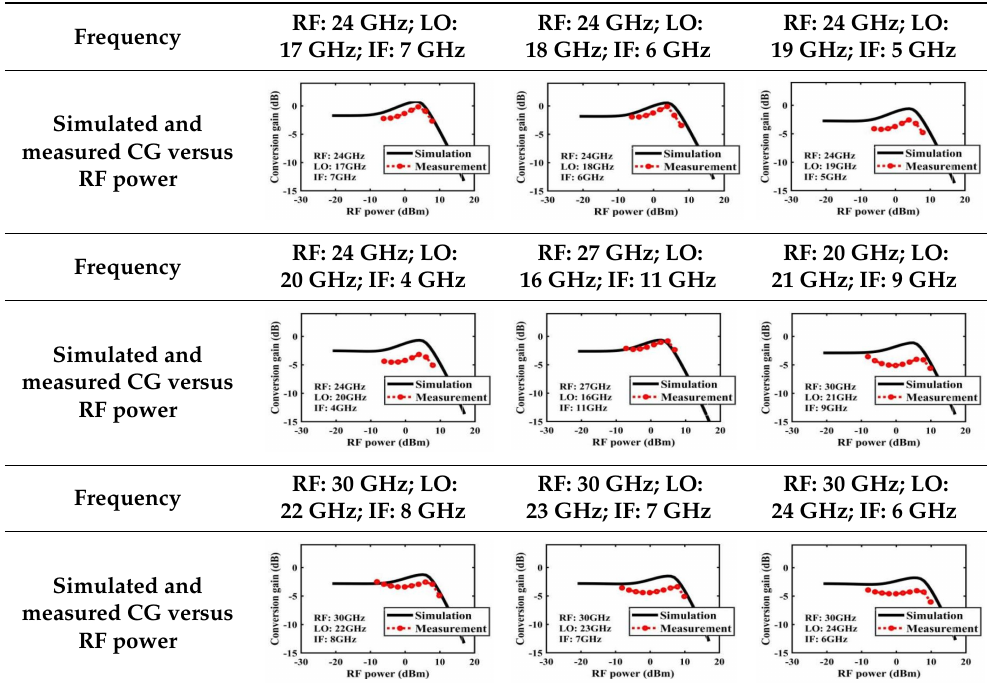
Table 3. Simulated and measured CG versus input power under nine different RF/LO/IF